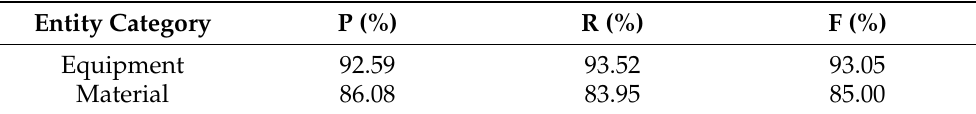
Table 4. Material and equipment identification rates.